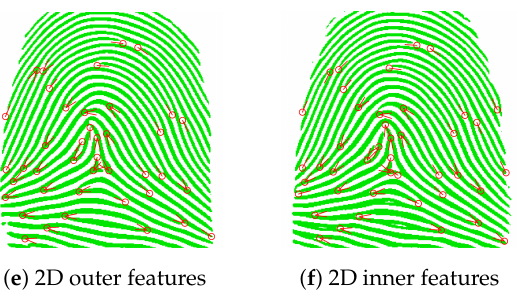
Figure 6. Segmentation results for the same finger: outer ( a ) and inner ( b ) fingerprint surface, their respective 3D-to-2D conversion result ( c , d ), and extracted minutiae points ( e , f ).